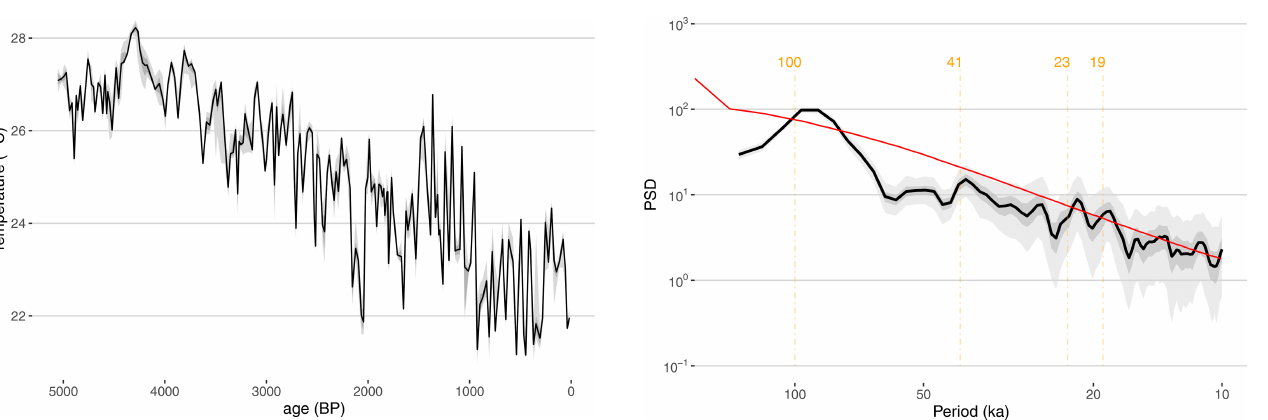
Figure 11. REDFIT spectrum for IODP 846. Median spectrum is shown in black, with the 50% and 95% highest-density probability ranges shown in dark and light gray, respectively. Periodicities of interest (in ka) are shown in